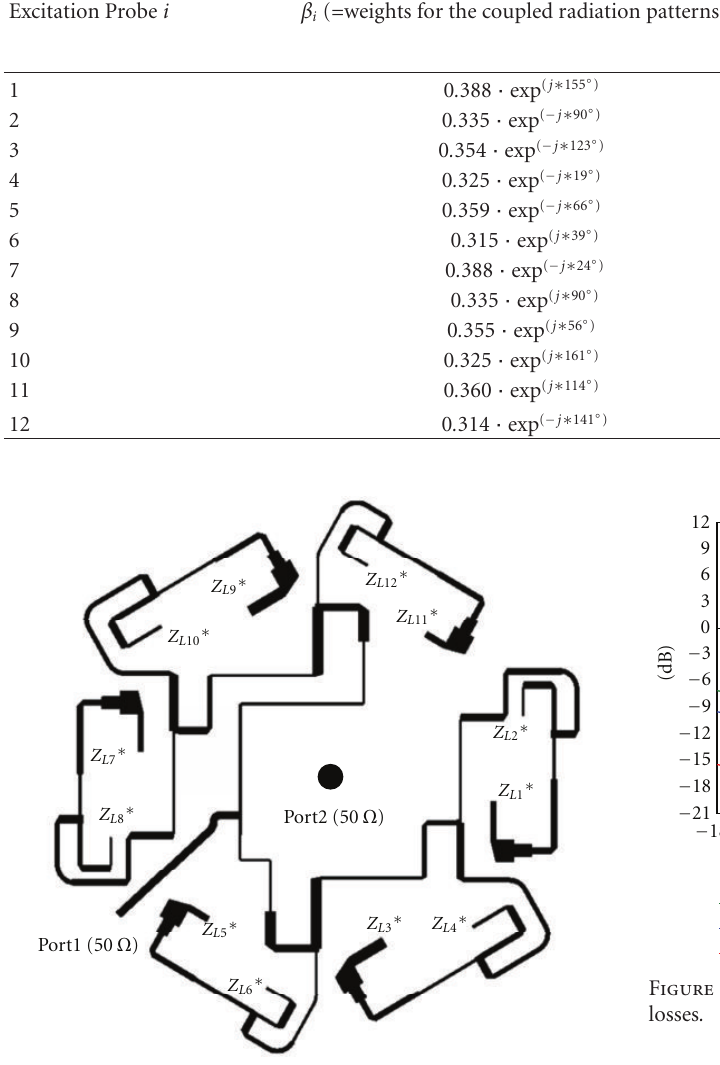
Figure 12: The feed network is designed to maximize the e ffi ciency of the strongly coupled patches.